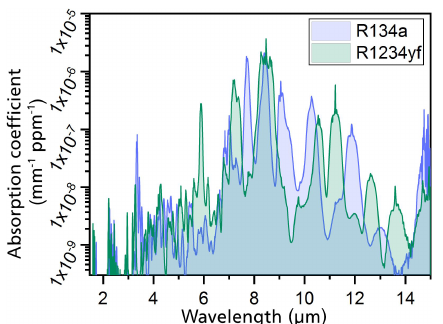
Figure 3. The dependence of the spectral absorption coefficients of the R134a and R1234yf refrigerants on the IR wavelength (Weber et al.,